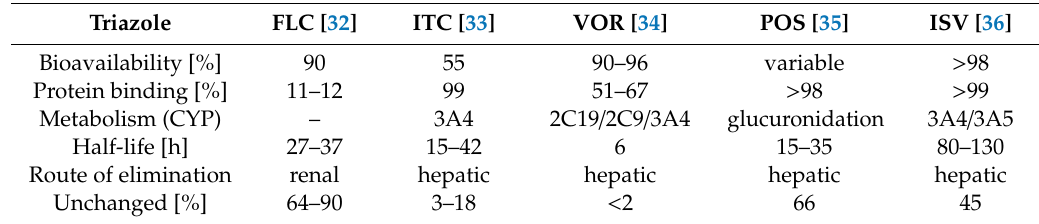
Table 1. Pharmacological properties of triazoles.